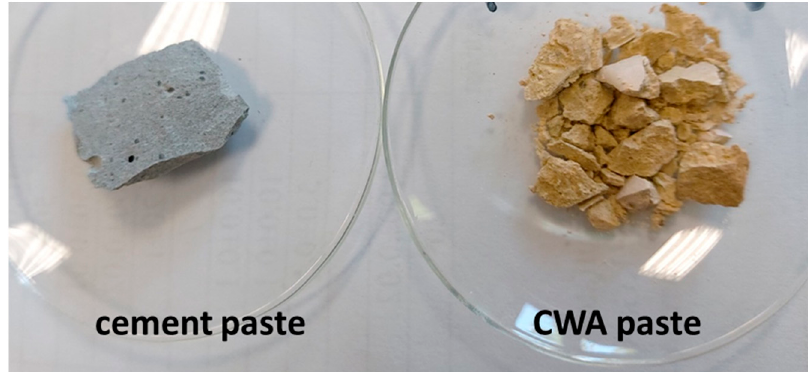
Figure 4. Macroscopic appearance of two pastes (cement paste and CWA paste) .